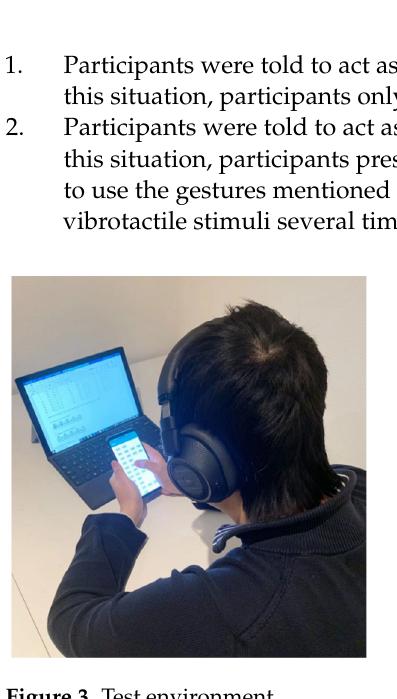
Figure 2. Test interface. This figure was extracted from [7].